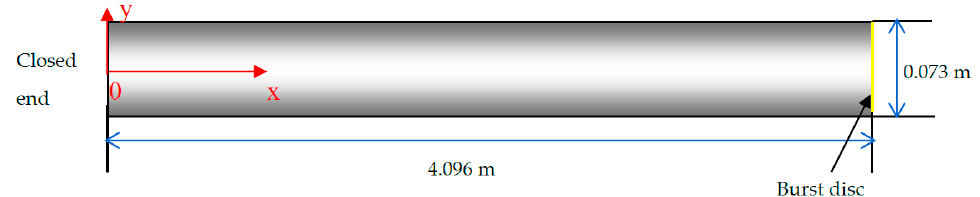
Figure 1. Edwards and O’Brien blowdown test.